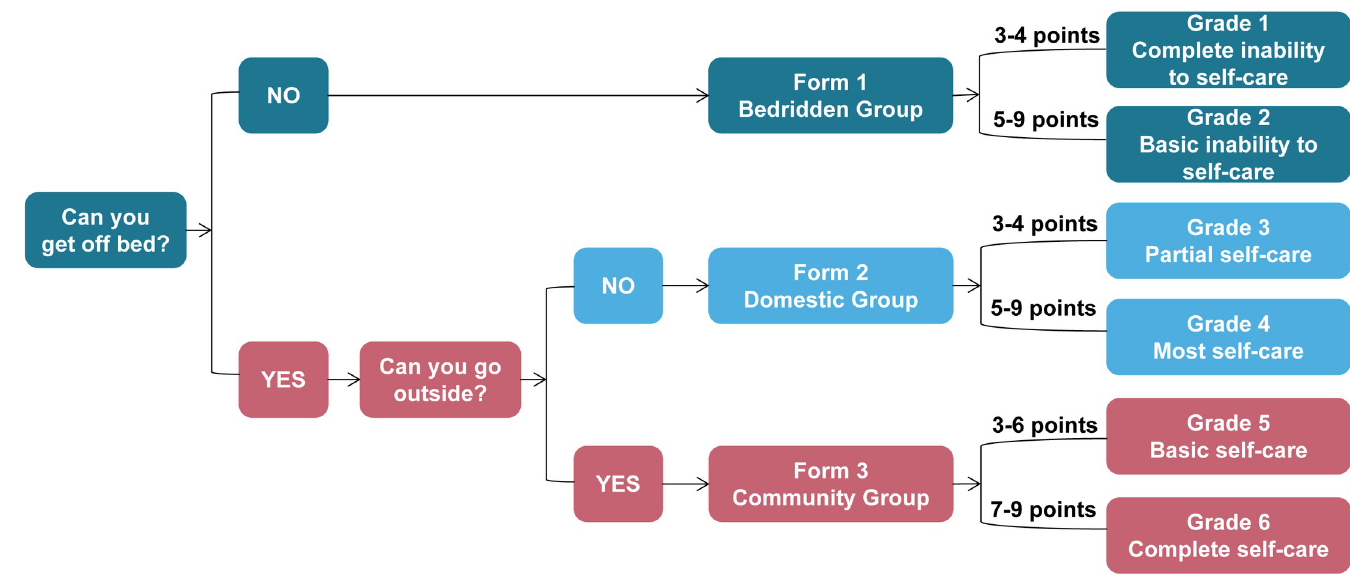
Fig 1. The Longshi Scale classification